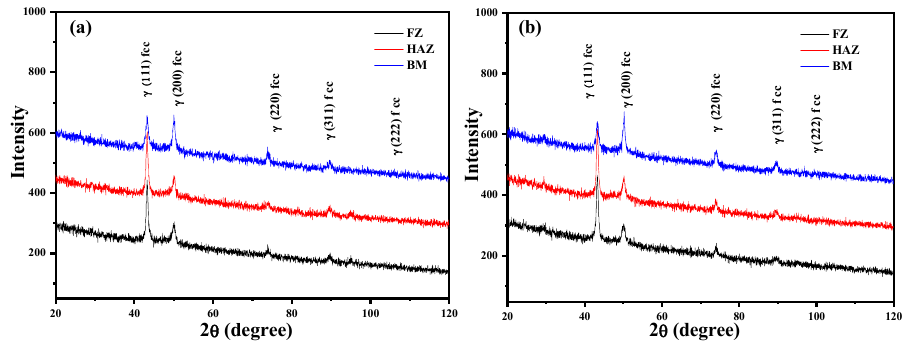
Figure 3. The micro-zone X-ray di ff raction (XRD) patterns of welded joints, including base metal (BM), heat-a ff ected zone (HAZ) and fusion zone (FZ), under di ff erent welding speeds: ( a ) 1.5 m / min and ( b ) 2.5 m / min.